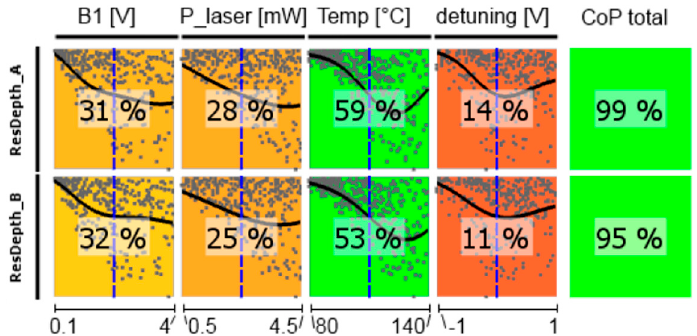
Figure 14. CoP matrix of the resonance depths for the medium-pressure magnetometer. Since the resonance depth is calculated as the difference between peak current and minus dc level, the values are negative. So, lower values means higher absorption. Approximation technique: isotropic kriging.